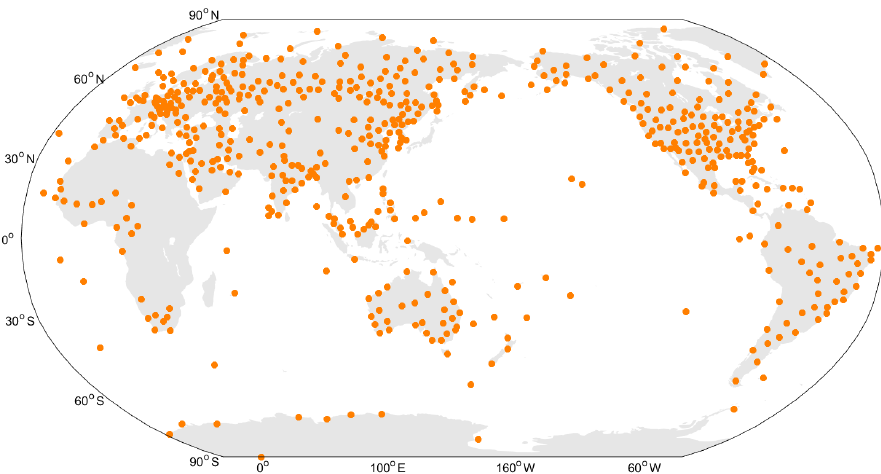
Figure 1. Distribution of the 585 radiosonde stations selected to validate the new GWMT-D model (only those data that pass a quality check are